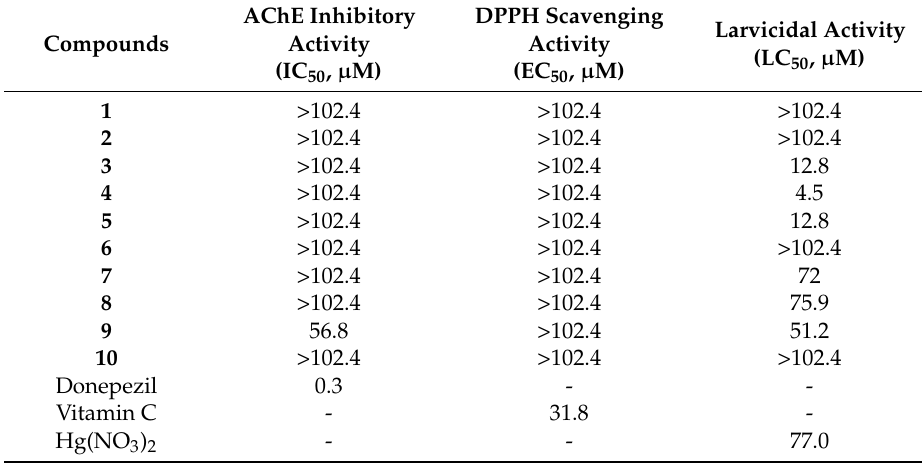
Table 4. AChE inhibitory activity, DPPH free radical scavenging activity, and larvicidality assay of compounds 1 – 10